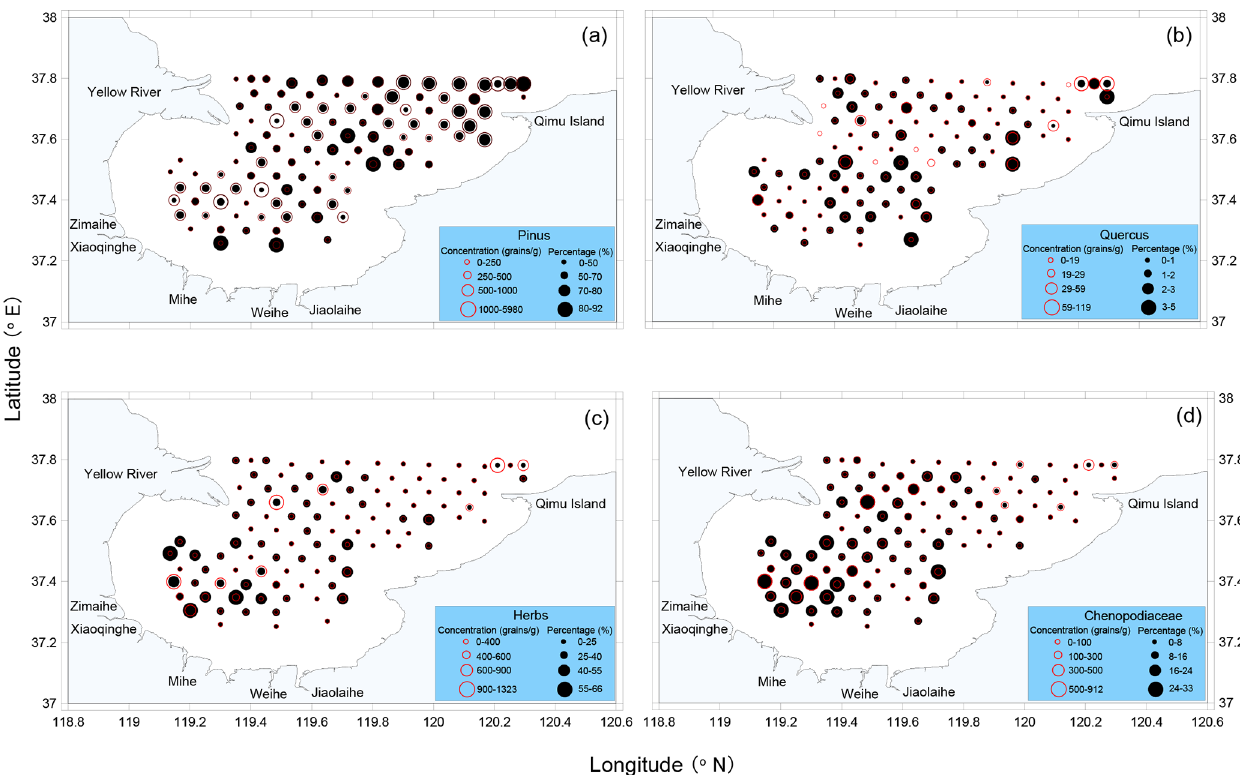
Figure 6. Spatial distribution of modern pollen percentage (solid black circle, %) and concentration (open red circle, grains per gram) in Laizhou Bay, Bohai Sea (modified from Yang et al.,